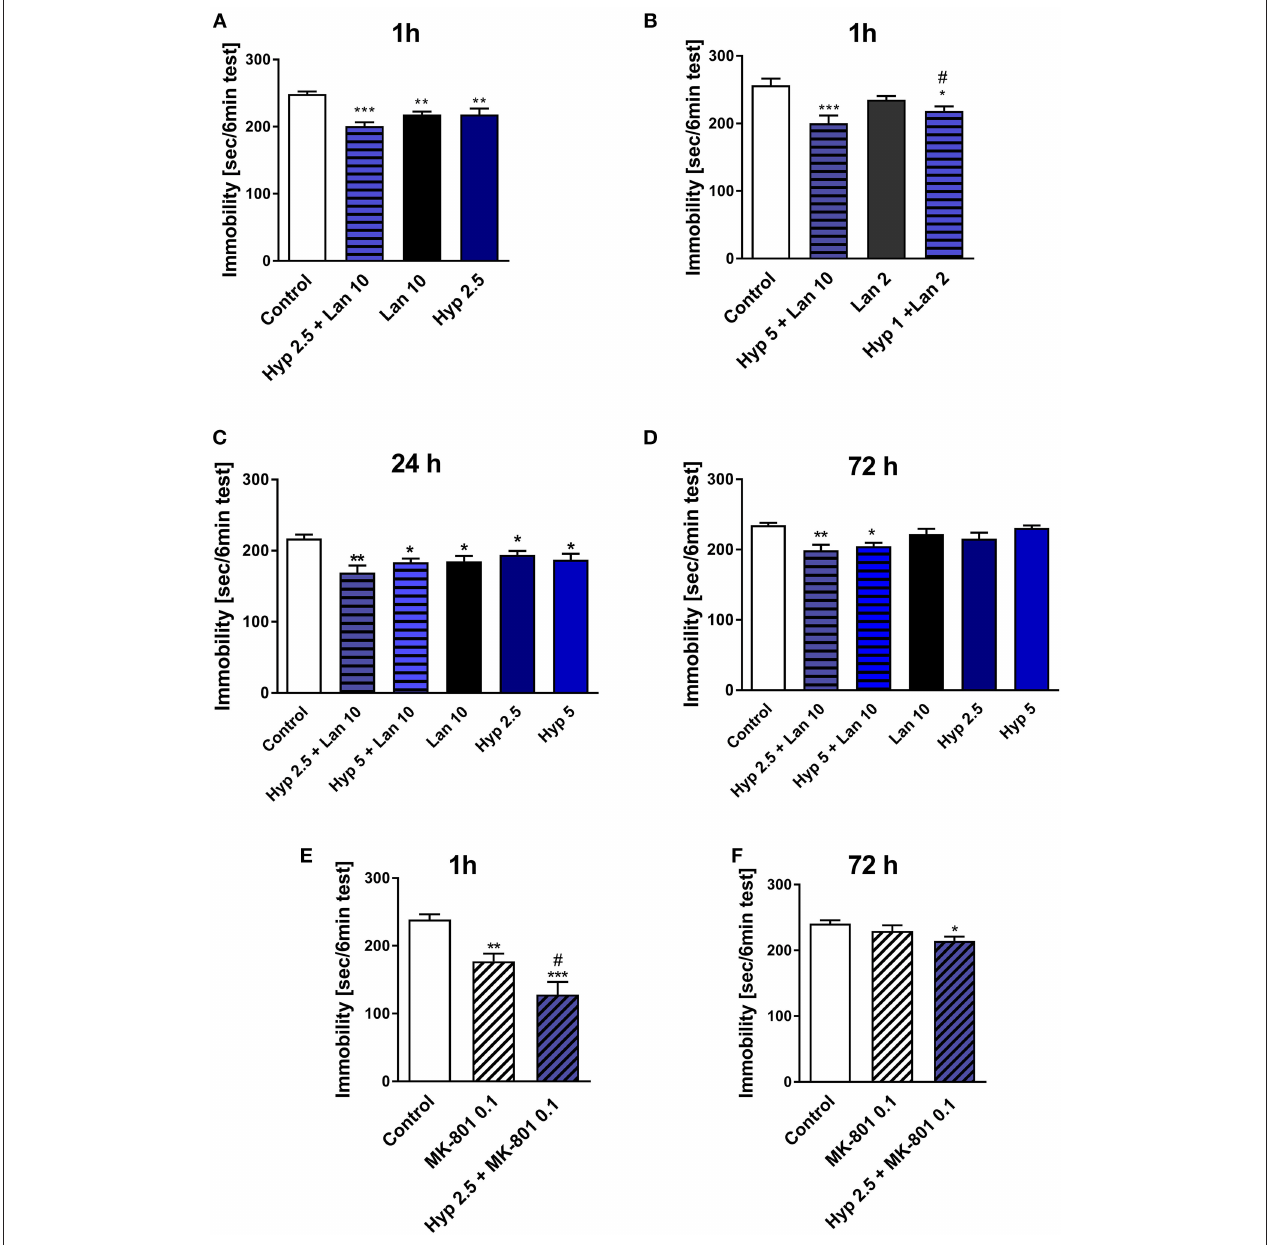
FIGURE 1 | The effect of combined administration of a single dose of hyperforin (Hyp) and NMDAR antagonists: lanicemine (Lan) and MK-801 in TST in mice. (A,B) Lanicemine (2 or 10 mg/kg; i.p .) was administered 90min before the TST and 30min before hyperforin (1, 2.5, or 5 mg/kg; i.p .) treatment. *** p < 0.001 vs. control, ** p < 0.01 vs. control, * p < 0.05 vs. control, # p < 0.05 vs. lanicemine 10 + Hyp 5, n = 7–8; [A: F (3,22) = 10.65; p = 0.0002], [B: F (3,22) = 7.405; p = 0.0013]. (C,D) Hyperforin and lanicemine were administered in the same way as in (A,B) but the TST was carried out 24h (C) or 72h (D) after hyperforin treatment. ** p < 0.01 vs. control, * p < 0.05 vs. control, n = 7–8; [C: F (5,38) = 4.376; p = 0.003], [D: F (5,39) = 5.063; p = 0.0011]. (E,F) MK-801 (0.1 mg/kg; i.p